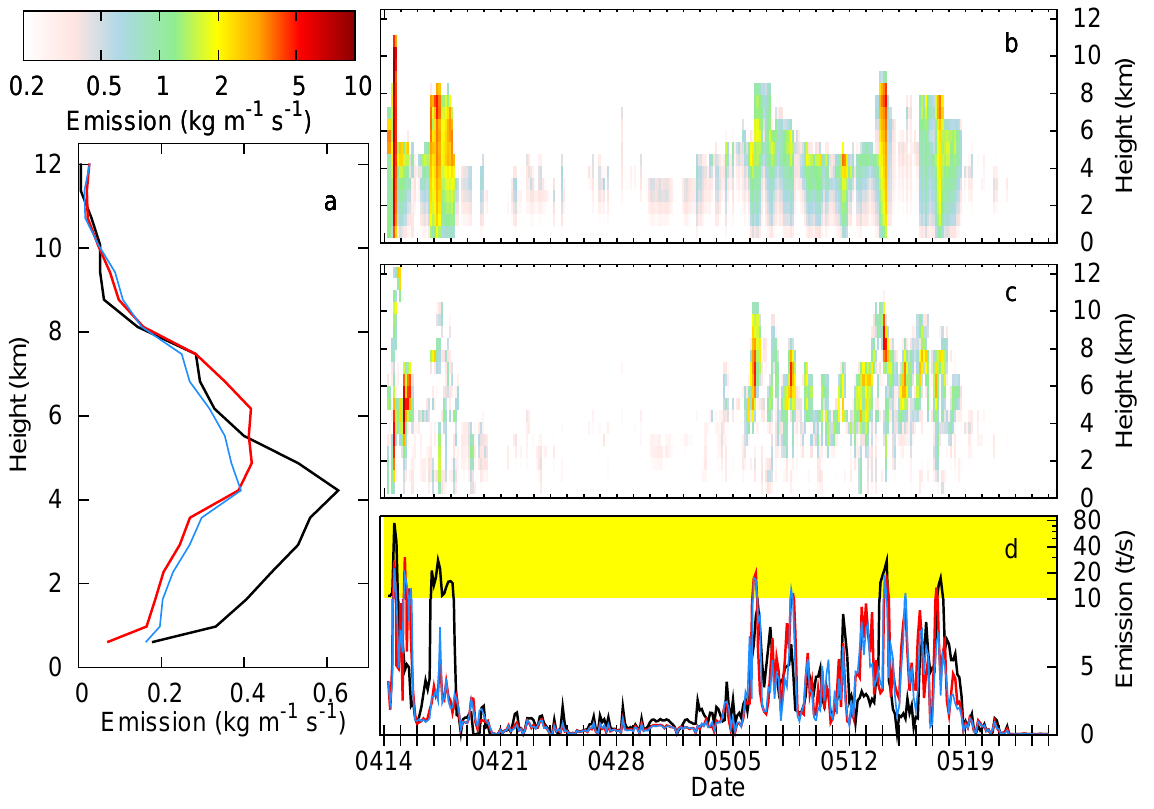
Fig. 2. A priori and a posteriori ash emissions. (a) Comparison of temporally-averaged vertical profiles of ash emissions used a priori (black line) and obtained a posteriori by the inversion when using ECMWF meteorological data (red line) and GFS meteorological data (blue line). (b) A priori emissions as a function of altitude and time for the period 14 April to 24 May 2010. (c) A posteriori emissions, averaged for the two inversions using alternative meteorological data sets, as a function of altitude and time. (d) Vertically integrated a priori (black line) and a posteriori emissions (red and blue lines) as a function of time. Notice the switch from a linear to a logarithmic scale above 10ts − 1 (yellow area). All heights throughout the paper are given in meters above sea